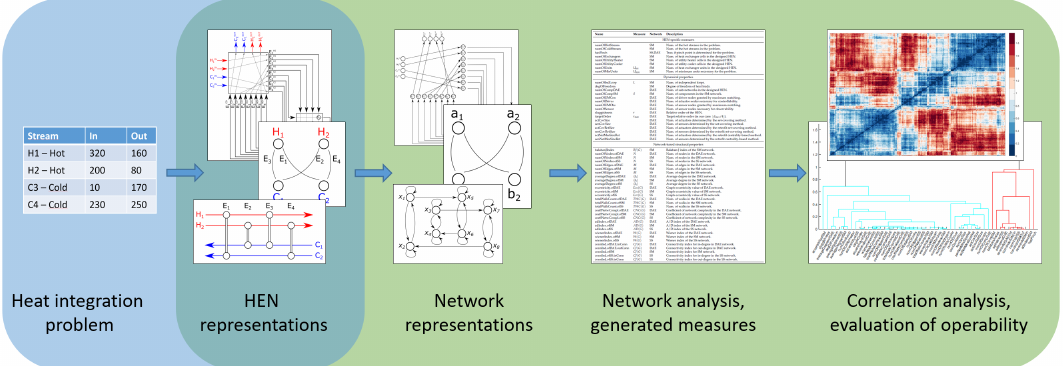
Figure 1. Workflow of the proposed